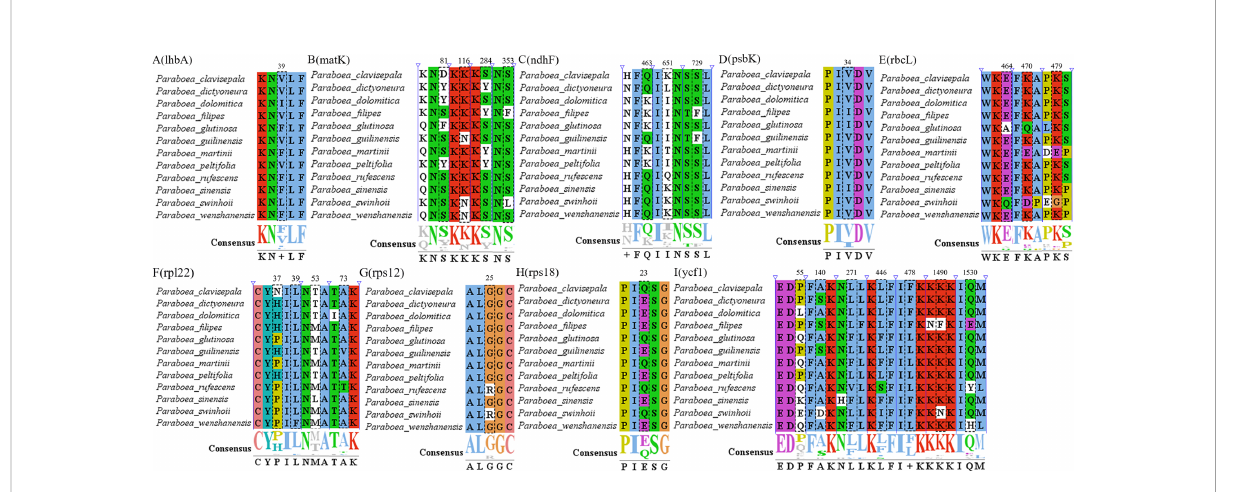
FIGURE 7 Nine genes of positive selection of amino acid sequences in site model tests.